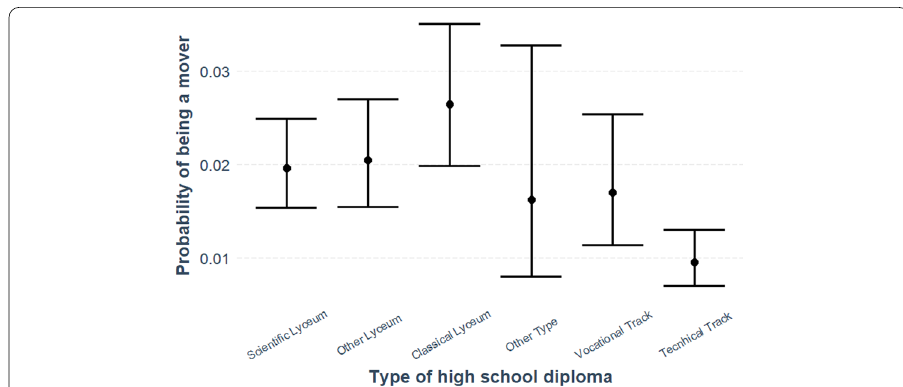
Fig. 4 Model 2: estimated marginal probabilities with respect to high school diploma type